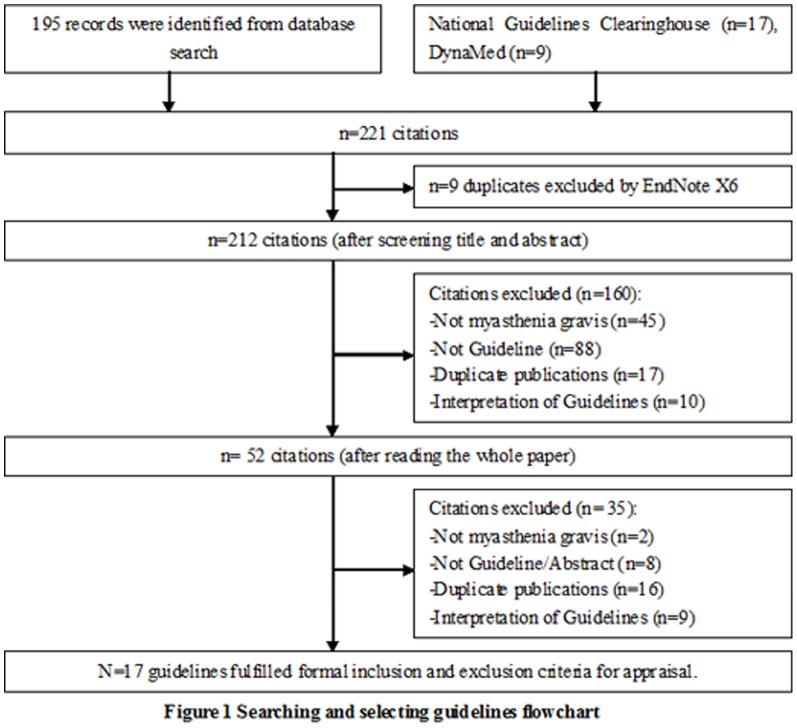
Searching and selecting guidelines flowchart.